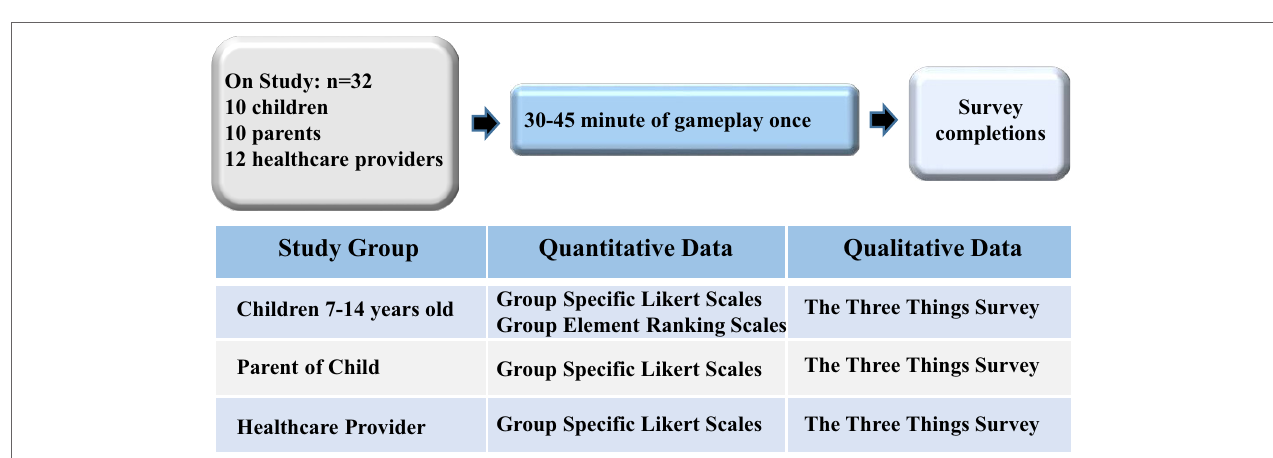
FigUre 2 | The prototype Empower Stars! video game usability assessment design involved a single gameplay session by three distinct yet related study populations as previously detailed, and included collection and analysis of both quantitative and qualitative data.